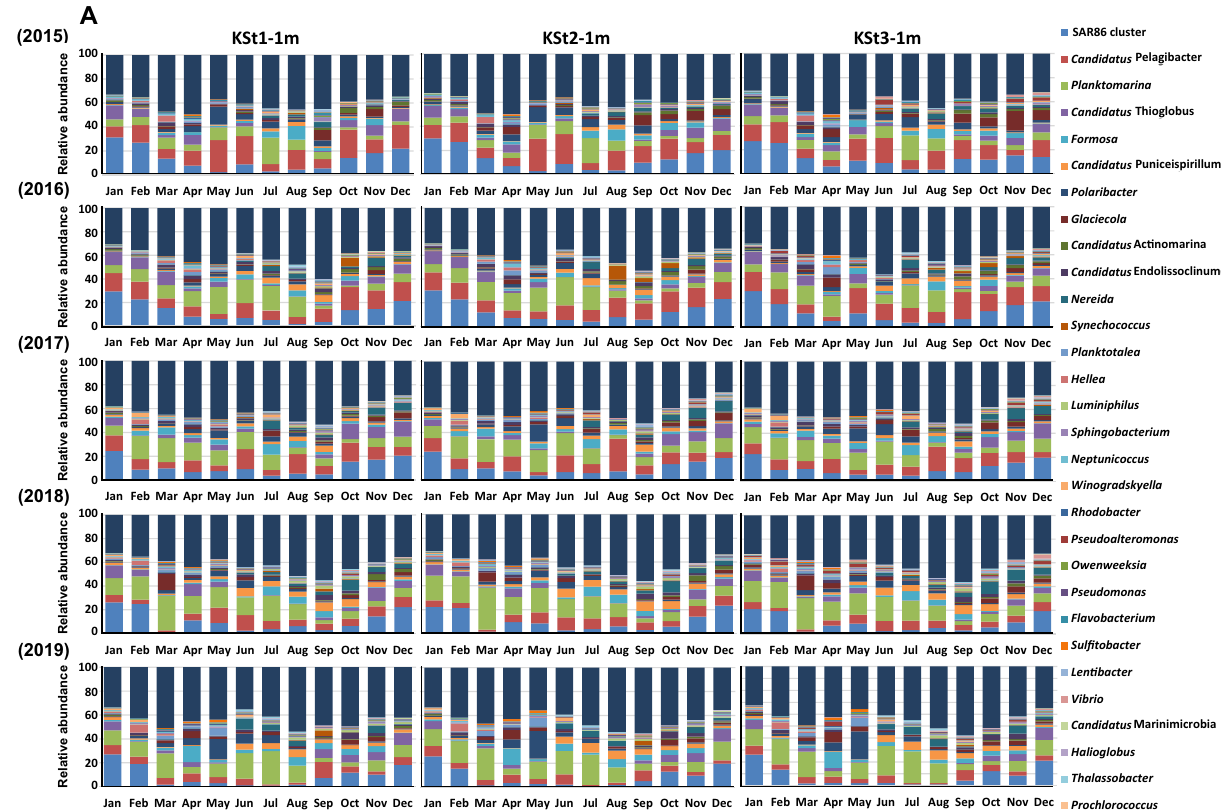
Figure 2. Seasonal and annual changes in the bacterial community at the genus level for seawater samples collected from the 1 m and 8 or 10 m depths at KSt. 1, KSt. 2 and KSt. 3 in Ofunato Bay from 2015 to 2019. While the seawater samples collected were serially passed through 20-, 5-, 0.8- and 0.2-µm pore size filters, only the cells trapped on the 0.2-µm filters were subjected to WGS sequencing. Panels ( A ) and ( B ) show data for the 1 m and 8 or 10 m depths, respectively. Refer to the legend of Fig. 1 for sampling